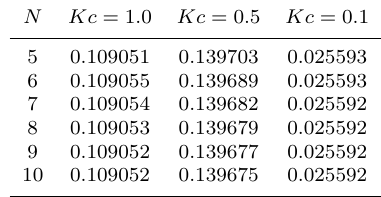
N Kc = 1 . 0 Kc = 0 . 5 Kc = 0 . 1 5